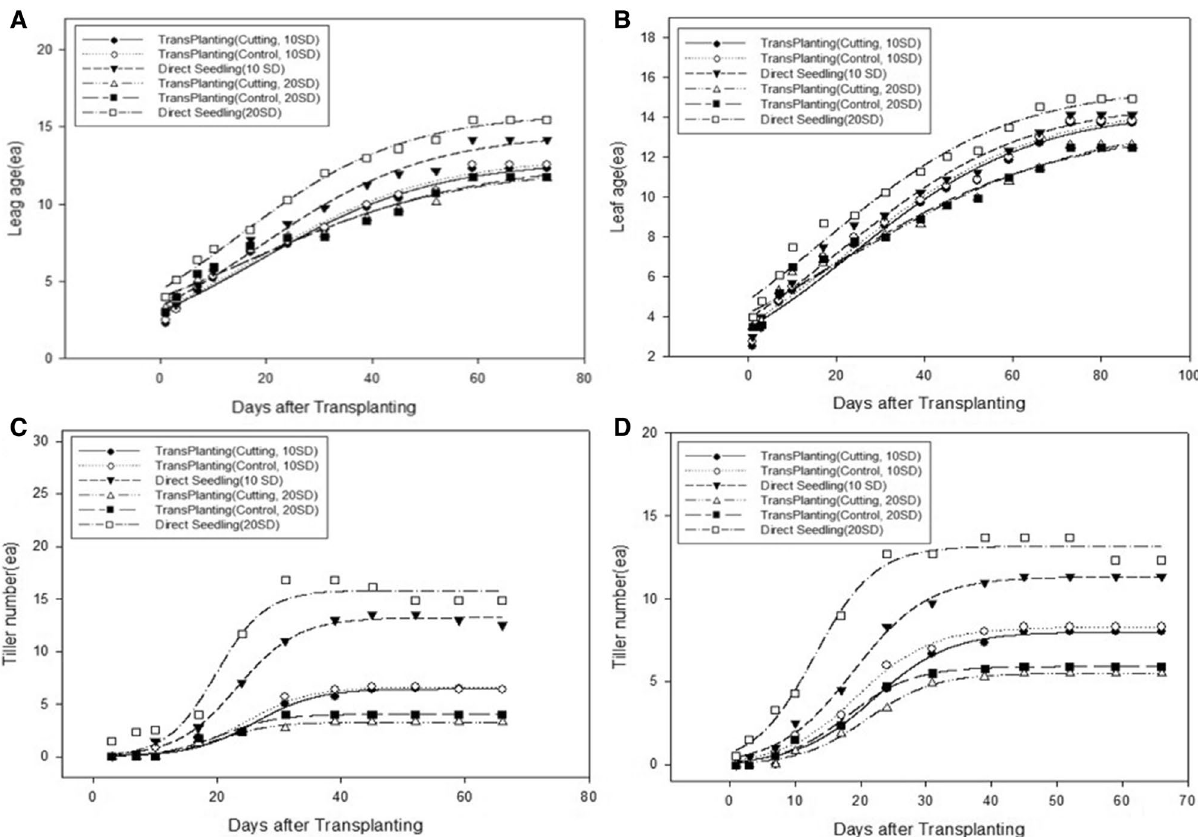
Figure 5. The degree of rice leaf age and tiller development after transplanting in response to root cutting conditions and seedling age. ( A ) Odae, leaf age; ( B ) Saenuri, leaf age; ( C ) Odae, tiller number; ( D ) Saenuri, tiller number.